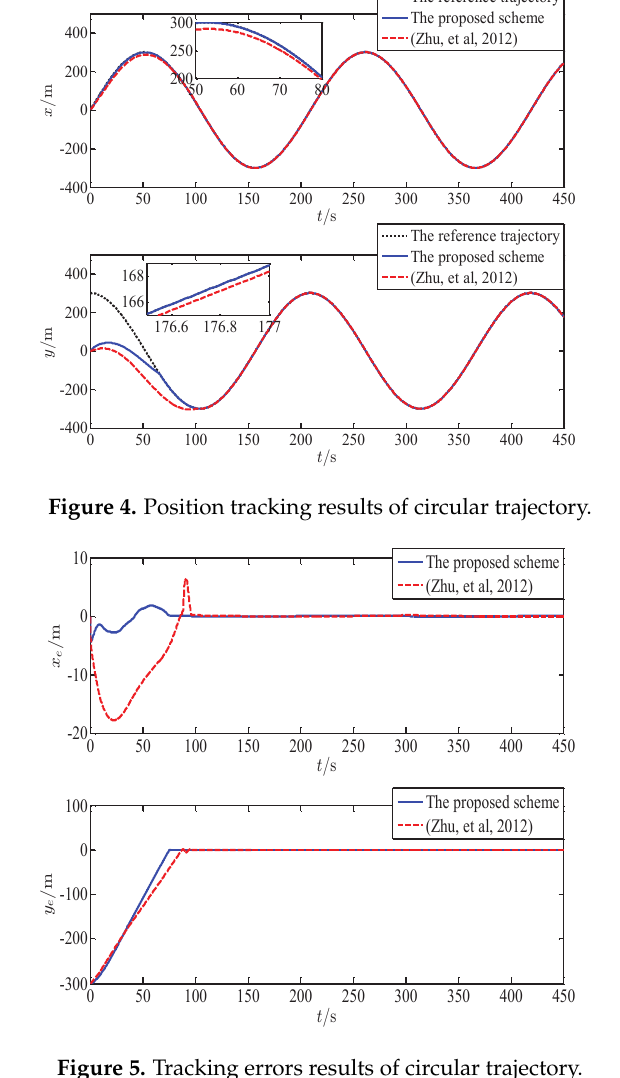
Figure 5. Tracking errors results of circular